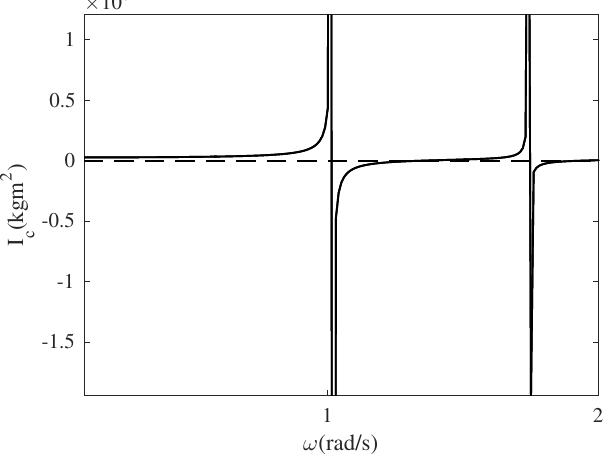
Figure 4. Variation of added inertia ( I c ) with wave frequency ( ω